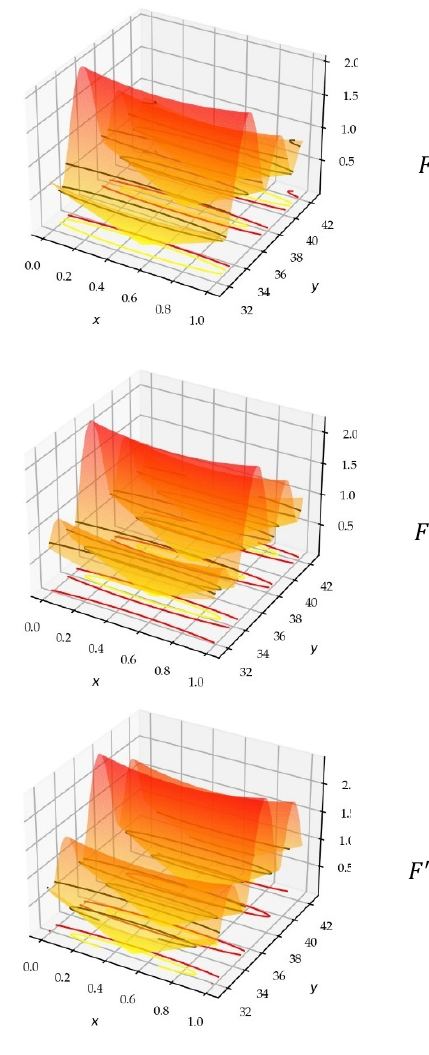
Figure 6. Drawings of several cross-sections of 𝐹(𝑠) , when 𝑠 is not a zero: ( a ) real; ( b ) imaginary. On these different cross- sections at constant 𝑦 of the 𝐹 function, we observe the two symmetries which are characteristic of the function. The imaginary part is equal to zero for 𝑥 = ½ , since they are cross-sections, not corresponding to non-trivial zeros. The colors are different depending on whether they are after a zero with an odd or an even index.